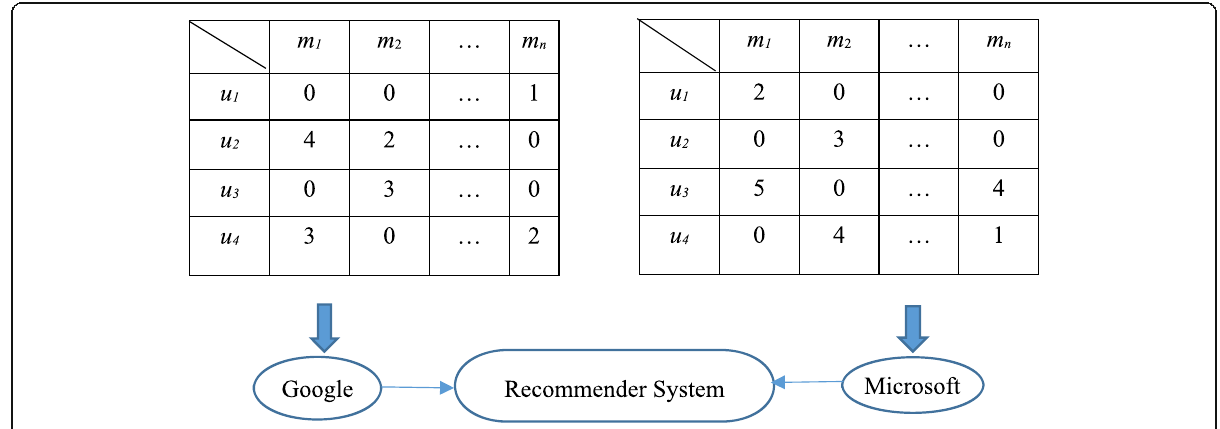
Fig. 1 Cross-edge recommendation with sparse data and privacy